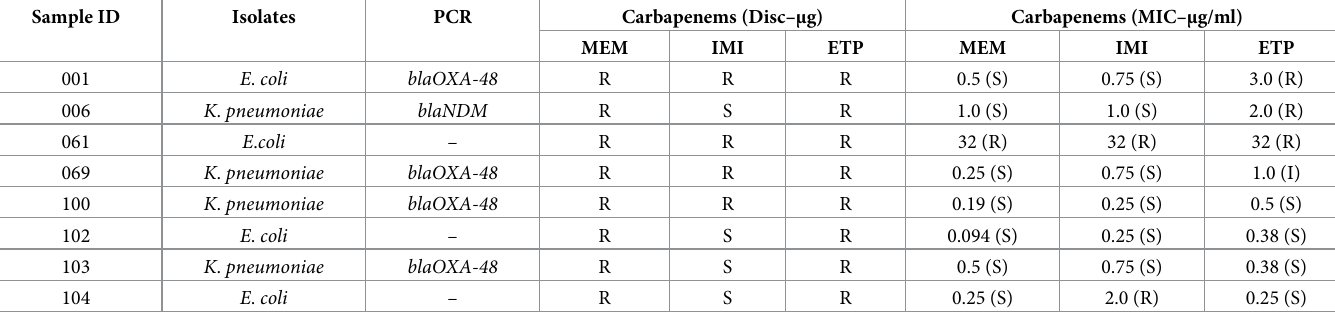
Table 3. Resistance genes and antibiogram of carbapenemase positive E . coli and K . pneumoniae isolates. Sample ID